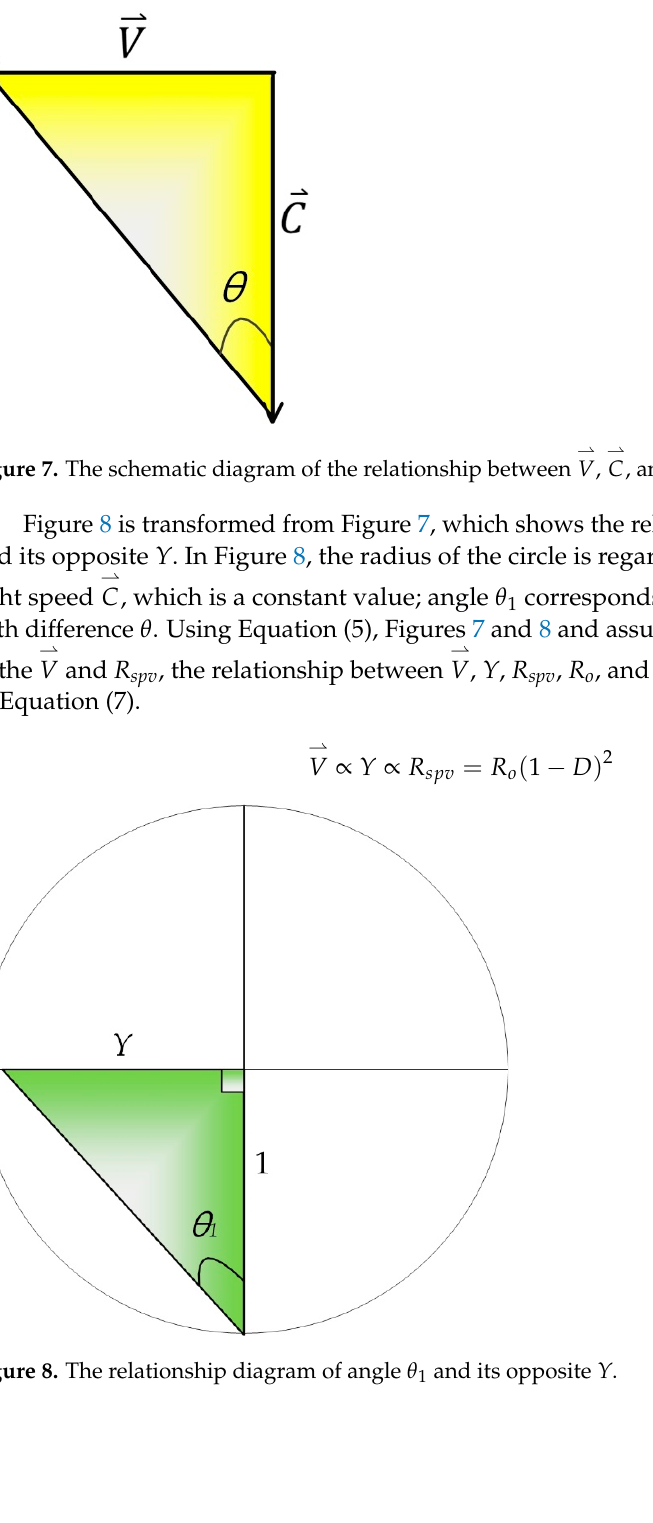
Figure 8. The relationship diagram of angle θ 1 and its opposite Y .